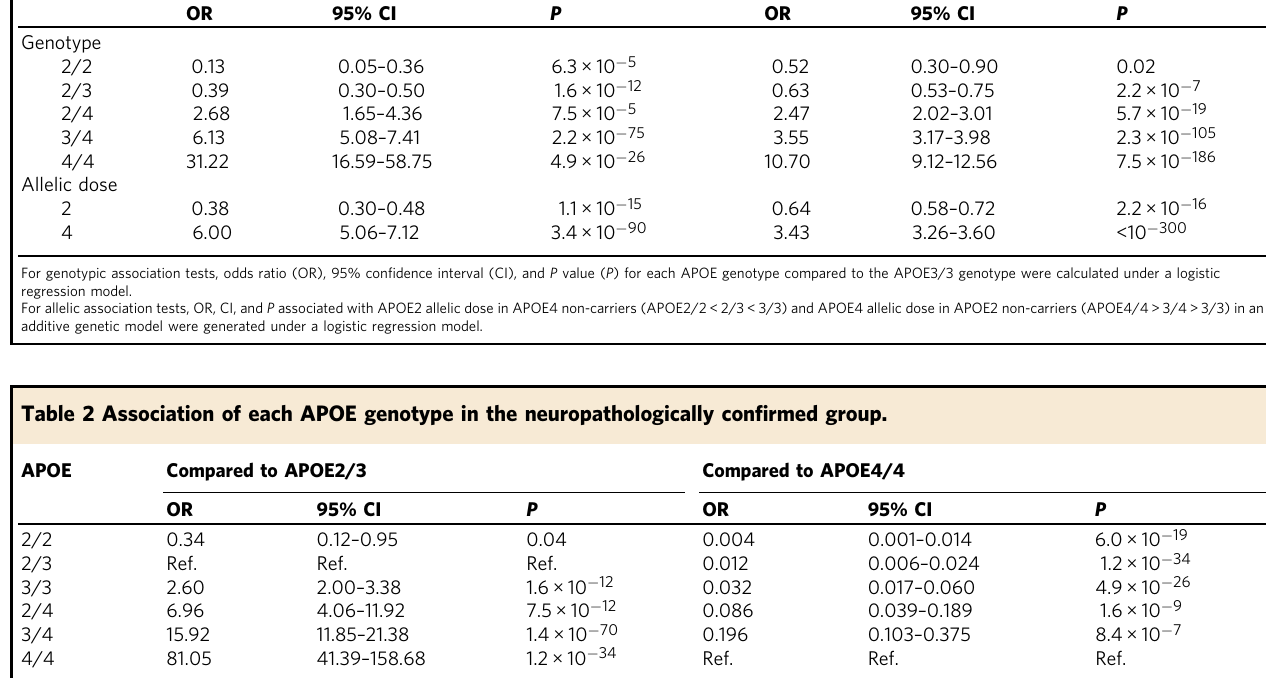
Table 1 Association of APOE genotypes and allelic doses compared to the APOE3/3 genotype. APOE Neuropathologically con fi rmed